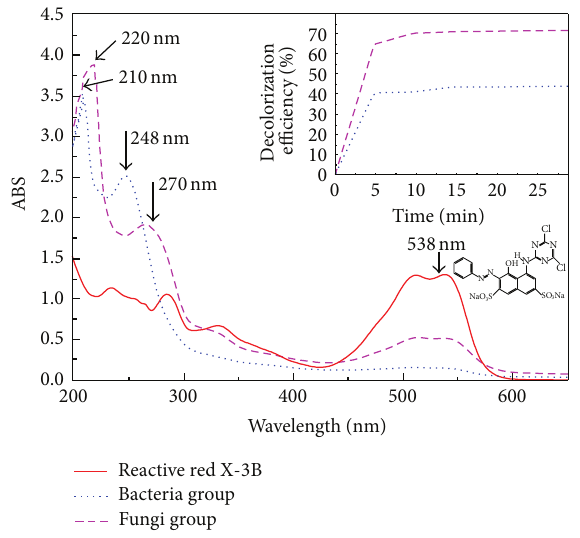
Figure 1: UV-vis spectra of the original reactive red X-3B and the residuals after culturing the bacteria and fungi groups in the BSM- dye medium for 3 days, respectively; X-3B adsorption efficiencies of bacteria and fungi groups, respectively